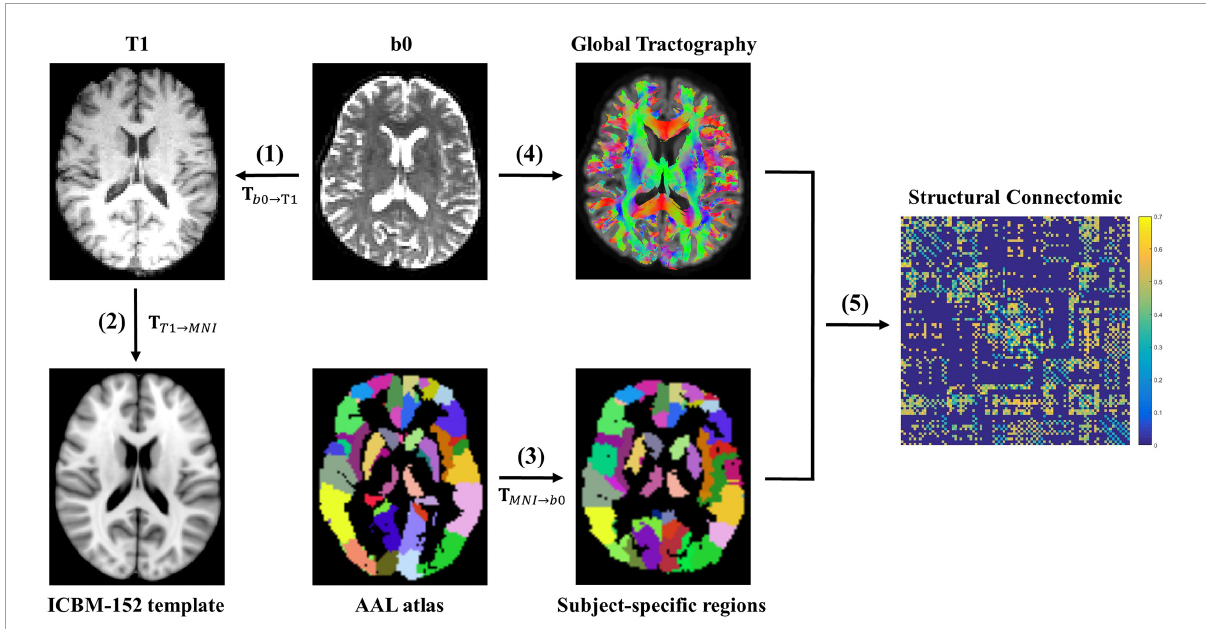
FIGURE1 The flowchart of white matter structural network construction. (1) The non-diffusion image b0 was co-registered to the corresponding T1-weighted image with an affine transformation T b 0 → T 1 for each participant. (2) The T1-weighted image was non-linearly transformed to the Montreal Neurological Institute (MNI) space using the ICBM-152 brain template, resulting in a non-linear transformation T T 1 → MNI . (3) These two transformations (T b 0 → T 1 and T T 1 → MNI ) were inversed and combined into one transformation ( T MNI → b 0 ), which was applied to wrap the AAL from the MNI space to the native diffusion space of each participant. Thereafter, 90 participant-specific brain regions were created. (4) A whole-brain fiber reconstruction was performed for each subject in native space using the probabilistic tracking in conjunction with DTI. (5) Finally, the 90 × 90 symmetric connectivity matrix for each participant was constructed by calculating the mean FA values of streamlines that connect each region pair.